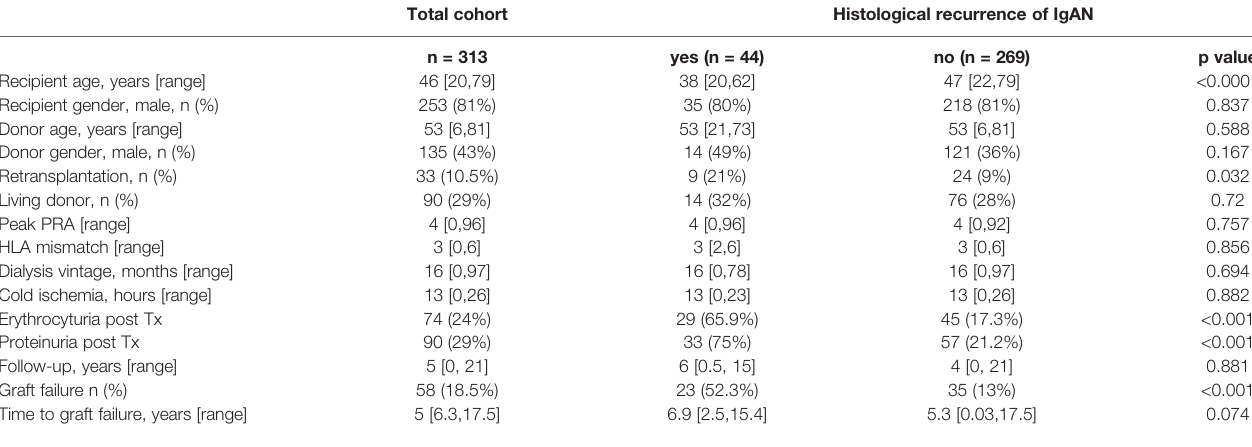
TABLE 2 | Patients with histological recurrence of IgAN, signi fi cant young recipient ’ s